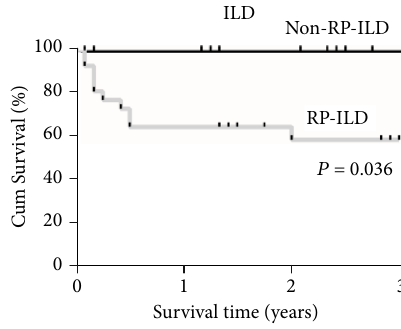
Figure 1: Kaplan-Meier survival curves for RP-ILD and non-RP- ILD groups in aMDA5-DM patients.